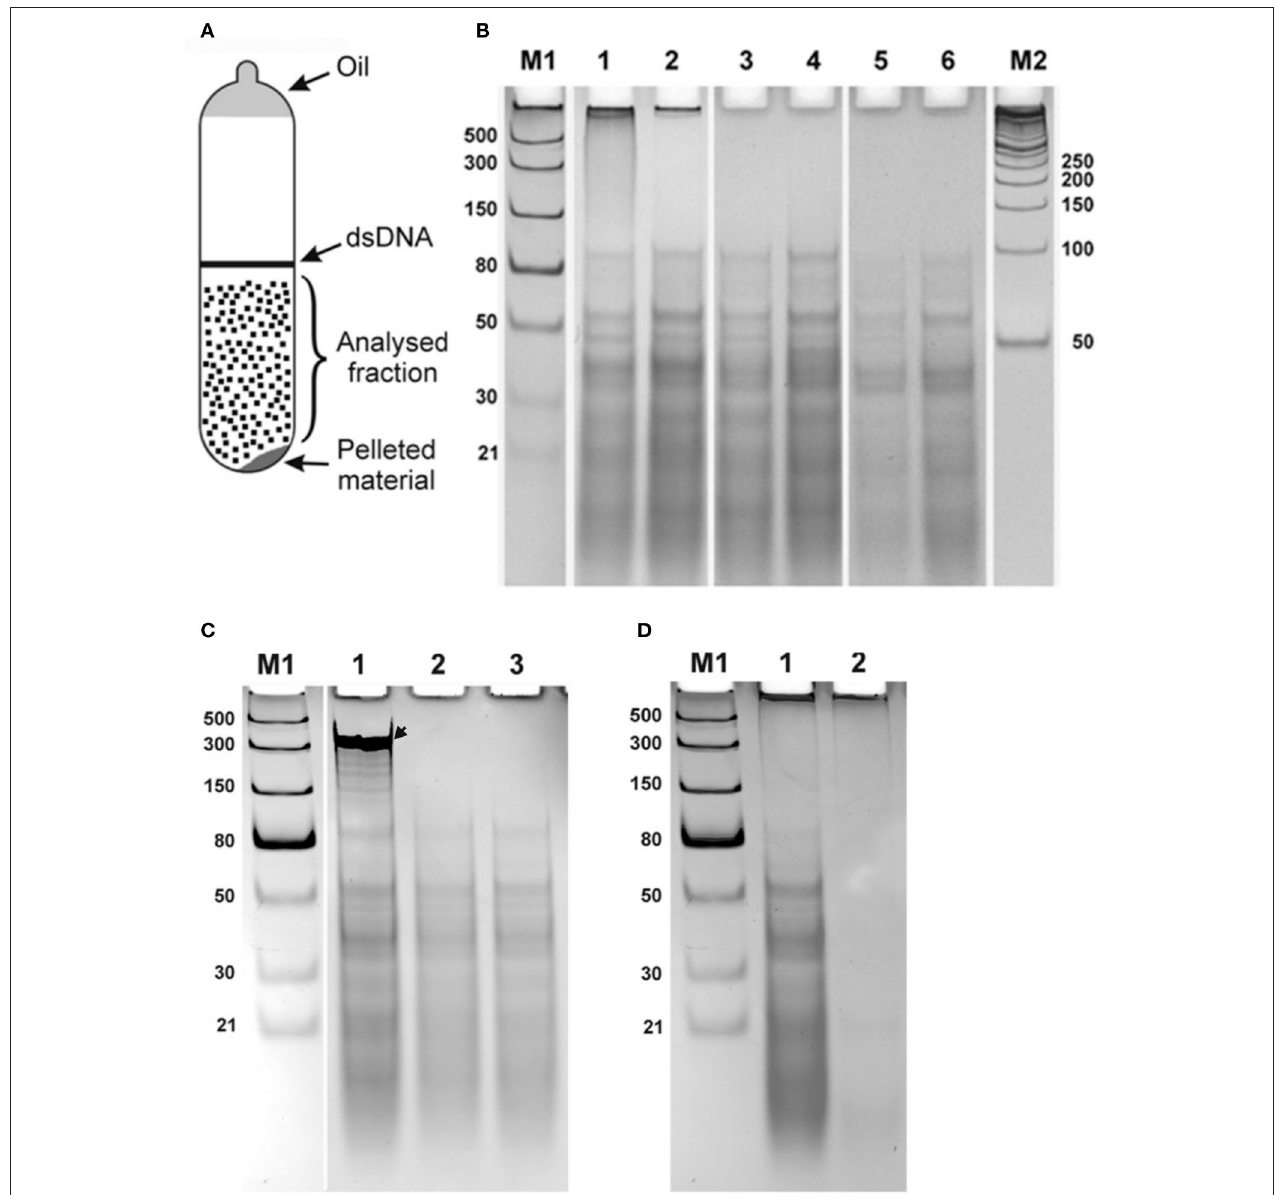
FIGURE 1 | Double stranded RNA from human seminal plasma. (A) Schematic representation of UV-visible fractions after equilibrium centrifugation of the human seminal plasma from CsCl-ethidium bromide density gradients. (B) Electrophoretic separation on a 10% polyacrylamide gel of the isolated diffused fraction of nucleic acids collected after centrifugation (“Analysed fraction” in A ). Nucleic acids isolated from seminal plasma of two different individuals are shown in lanes with even and odd numbers, respectively. 1, 2—Isolated material; 3, 4—Material treated with DNase I; 5, 6—Material treated with DNase I and RNase One Ribonuclease. The fraction located near the top of the gel was digested with DNase I treatment. However, the distinct bands spread over the region from ∼ 100 bp to the bottom of the gel were resistant to both enzymatic treatments. (C) Enzymatic treatments of CsCl dsRNA fractions. Each sample was spiked with an in vitro synthesized ssRNA, see arrow, as an internal control, treated with different nucleases, and then separated by electrophoresis and visualized. 1, DNase I treatment. 2, RNase One Ribonuclease treatment. 3, RNase R treatment. Both RNase One and RNase R ribonucleases digest the spiked in ssRNA but do not act on the nucleic acid, dsRNA, from the seminal fluid. (D) Electrophoretic separation of seminal plasma nucleic acids 1 without and 2 after treatment with RiboShredder RNase Blend. All RNAs in the sample were completely degraded. M1 and M2—ladders (dsRNA Ladder and 50 bp DNA Ladder, respectively).